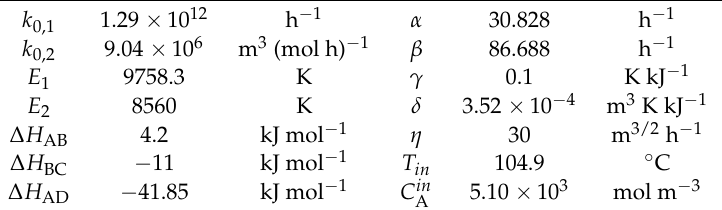
Table 2. Constants for the Van de Vusse reactor model (38).